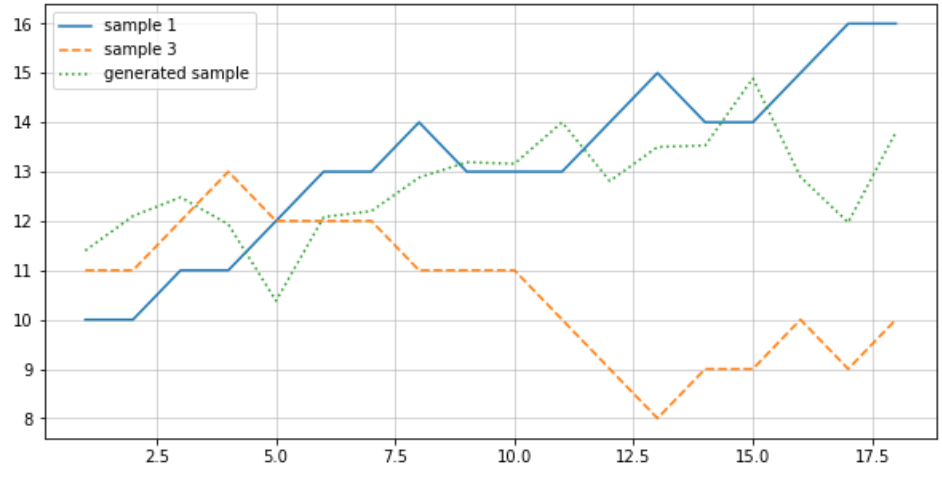
Figure 4. Generated sample example.